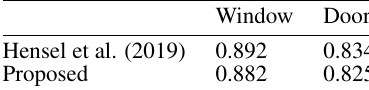
Table 1. Comparison of precisions on the ICG Graz50 dataset, with model trained on the CMP fac¸ade dataset.